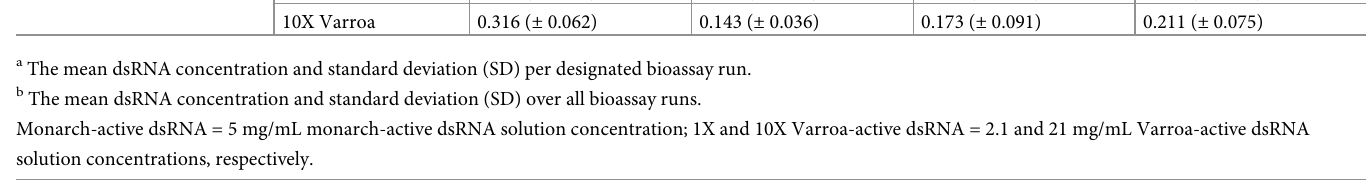
were analyzed. Measured concentrations for 2.1 (1X) and 21 (10X) mg/mL Varroa-active dsRNA ranged from 0.013 to 0.032 and 0.144 to 0.389 mg/g, respectively. The measured con- centration of monarch-active dsRNA ranged from 0.020 to 0.021 mg/g (Table 1). In the tropical milkweed bioassays, a subset of two to three leaves for each treatment group and run were analyzed. Measured concentrations for 2.1 and 21 mg/mL Varroa-active dsRNA ranged from 0.020 to 0.065 and 0.143 and 0.316 mg/g, respectively. The measured concentra- tion of monarch-active dsRNA ranged from 0.030 to 0.037 mg/g (Table 1). The 21 mg/mL treatment was 2- to 16-fold higher and 5- to 30-fold higher than the 2.1 mg/mL treatment in the tropical and common milkweed bioassays, respectively.